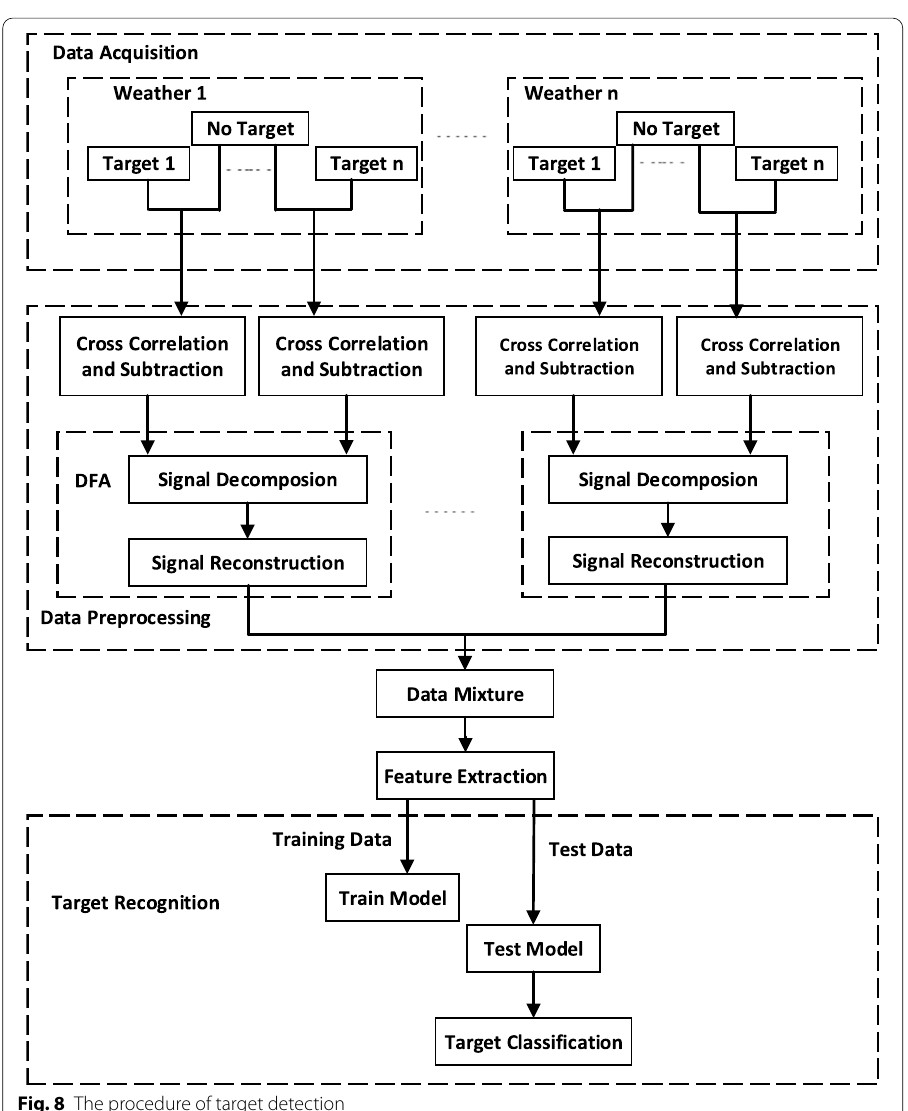
Fig. 8 The procedure of target